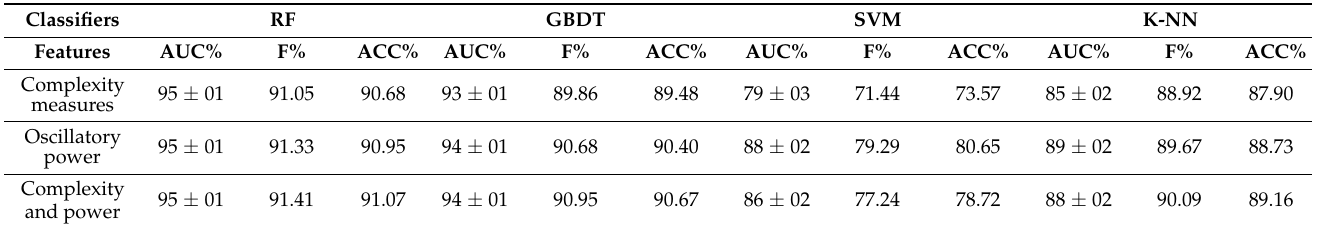
Table 5. Classification performance for the complexity measures, oscillatory power, and a combination of the two without the univariate feature